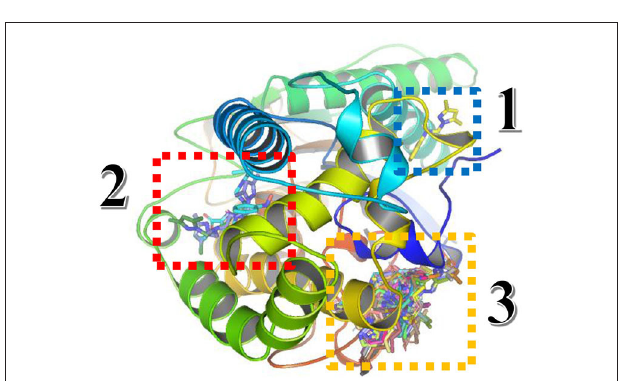
FIGURE 11 | Three-dimensional presentation of the three binding sites found by Blind docking/virtual screening.